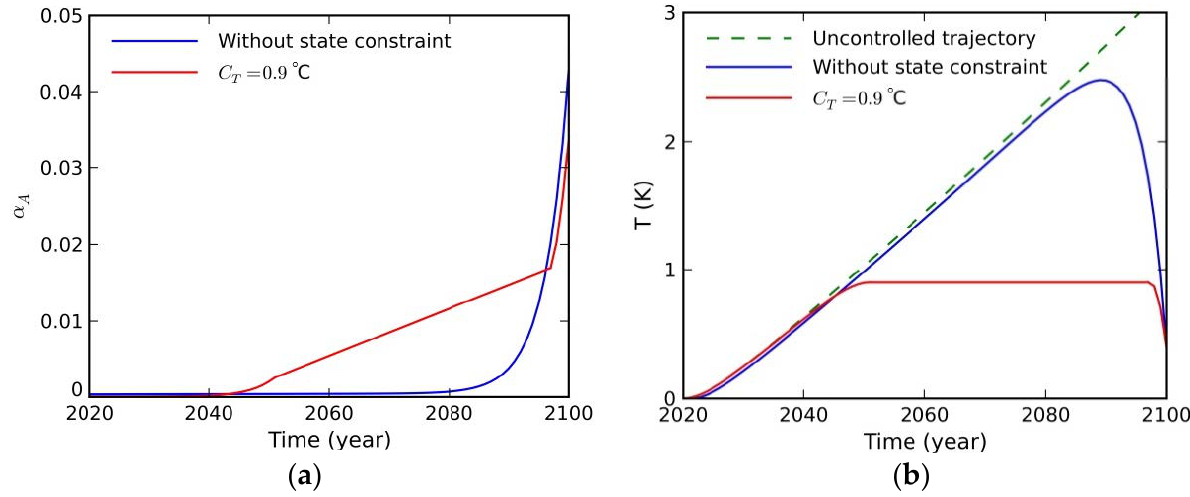
Figure 1. Optimal albedo of the aerosol layer ( a ) and the corresponding surface temperature anomalies ( b ) calculated with and without state constraint.